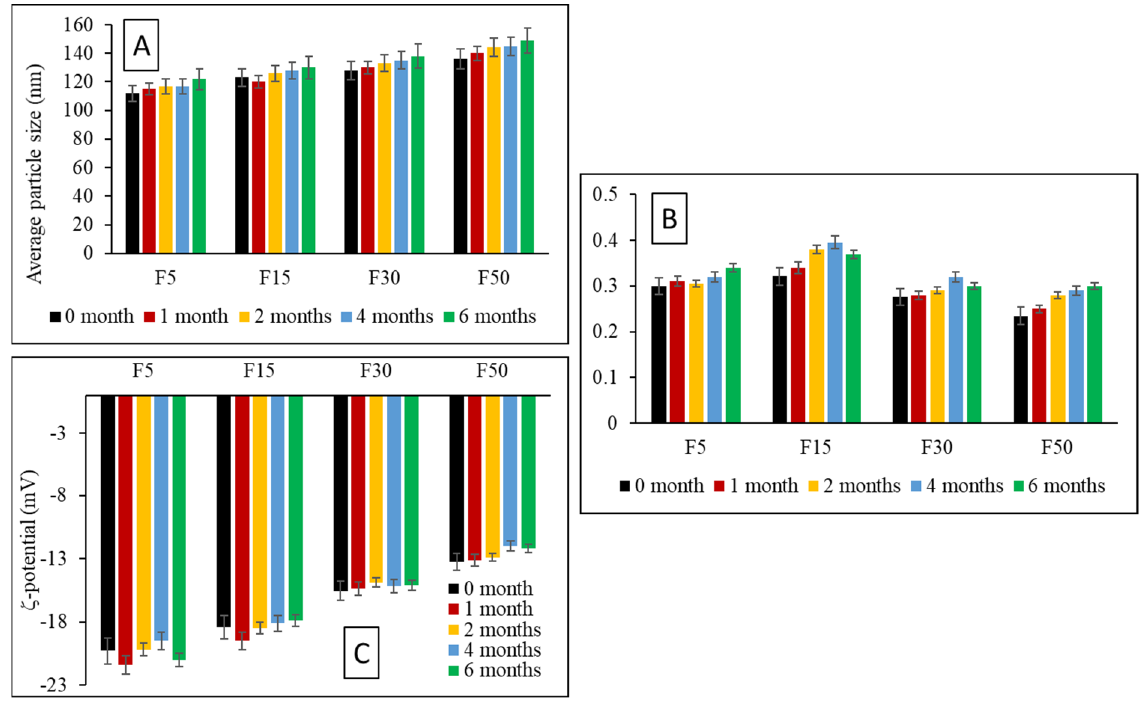
Figure 10. Effect of storage at 4 ± 1 °C on mean particle size ( A ), PDI ( B ) and ζ -potential ( C ) of OLZ-NLC formulations.